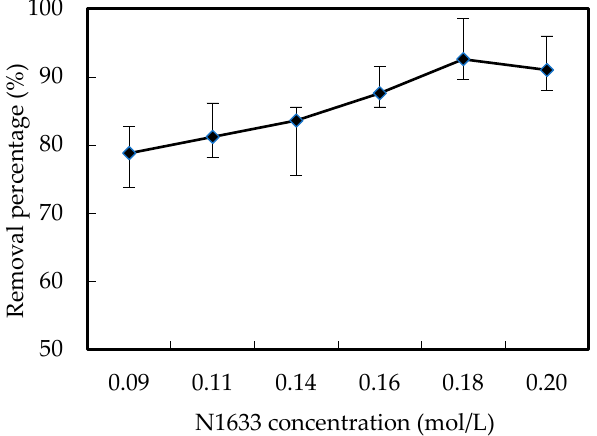
Figure 5. Effects of the N1633 concentration on the removal percentage of W (VI).